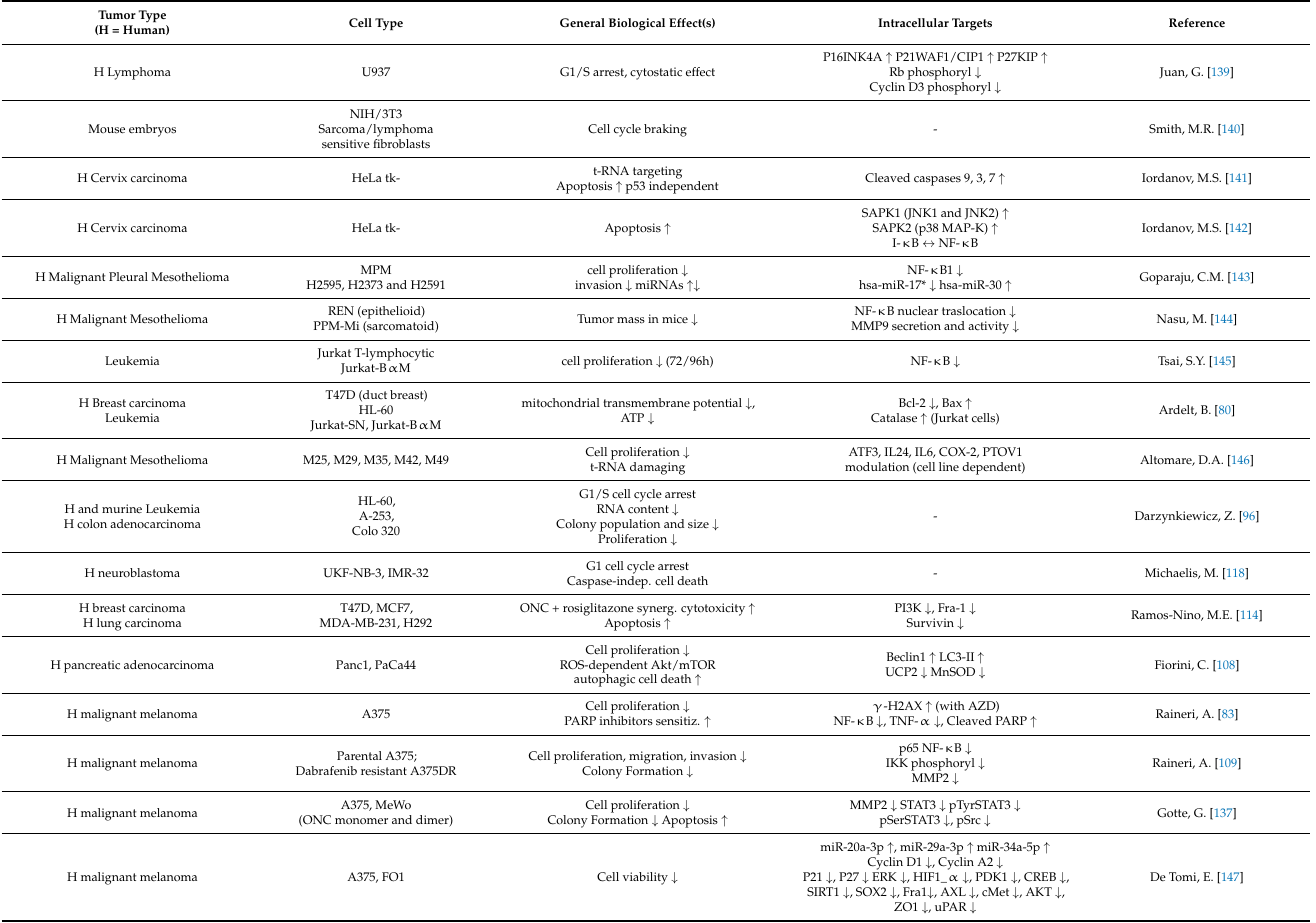
Table 1. Effects of ONC on tumors and/or in tumor